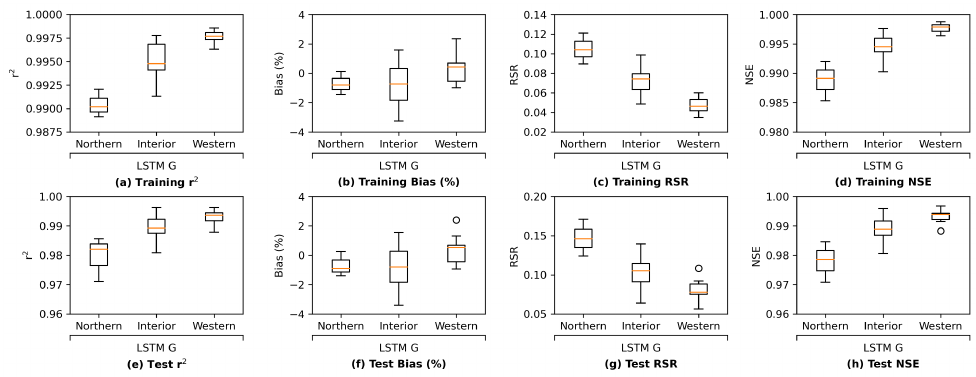
Figure 11. Box and whisker plots of four types of metrics consisting of r 2 , percent bias, RSR, and NSE on stations belonging to the northern, interior, and western Delta groups during the training (panels ( a – d )) and test (panels ( e – h )) phases of the grouped (G) LSTM